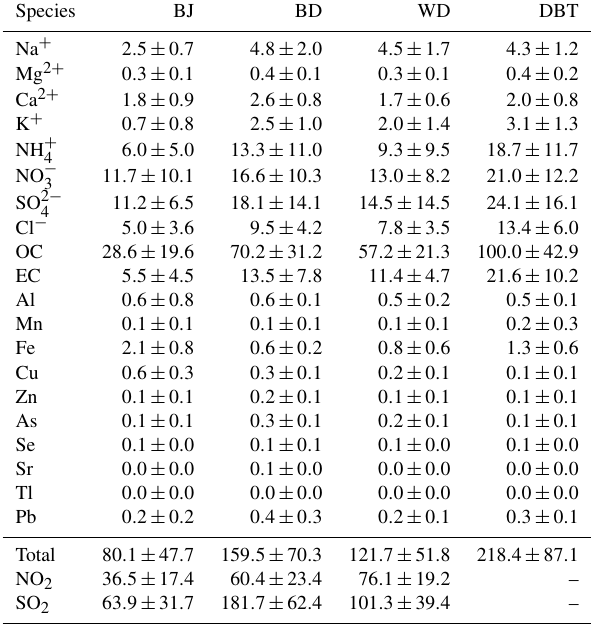
Table 3. The emission factors (mean ± SD; gkg − 1 coal) of OC and EC from residential coal combustion during the flaming combustion process, the smoldering combustion process and the entire combus- tion process. Emission The flaming The smoldering The entire factors combustion combustion combustion process process